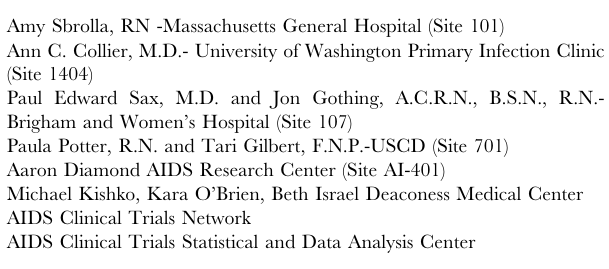
Figure 5. Lymphocyte proliferation responses (Stimulation Index) by antigen and treatment arm. Antiretroviral therapy was discontinued at study week 30. The symbol V indicates when vaccine or placebo was administered. The shaded area indicates the time period when subjects were off antiretroviral therapy.